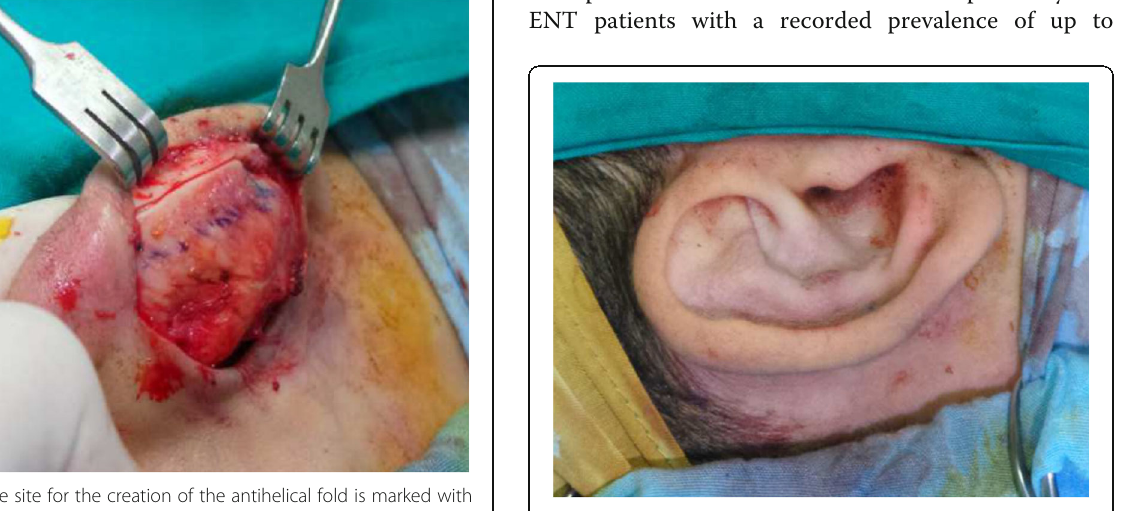
Fig. 6 At the end of the procedure, a well-formed antihelical fold is